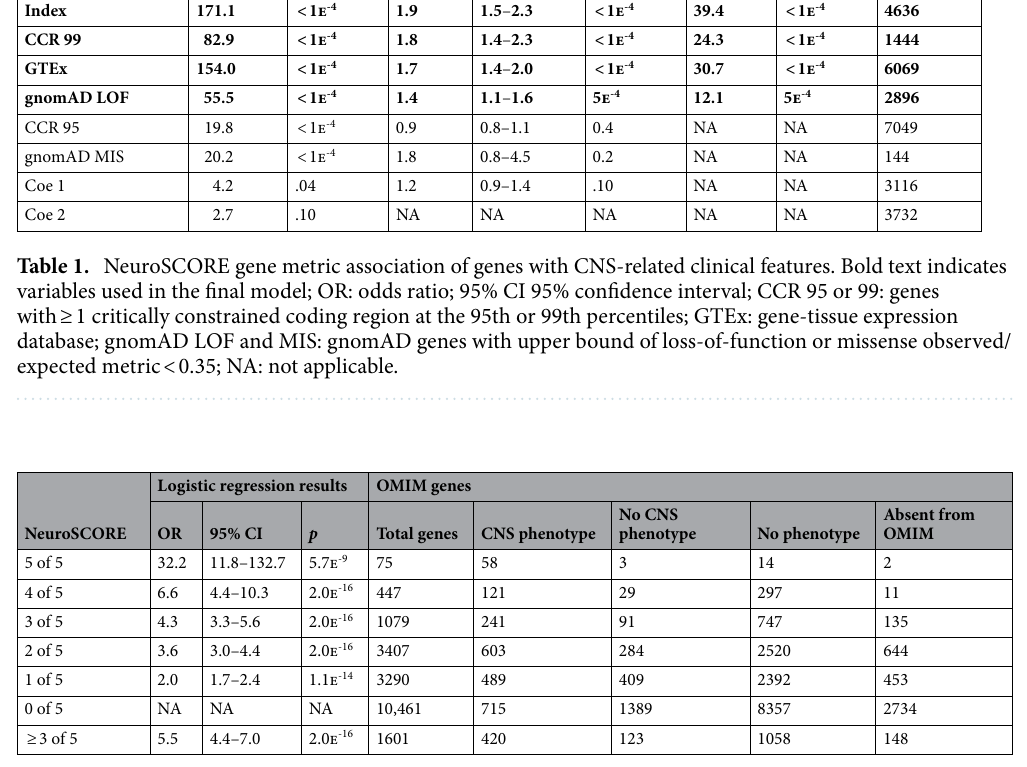
Table 2. NeuroSCORE model shows increasing odds ratios with increasing point totals. OR: odds ratio; 95% CI 95% confidence interval; NA: not available; high scoring genes are genes identified by ≥ 3 gene sets; OMIM data current as of July 31st,